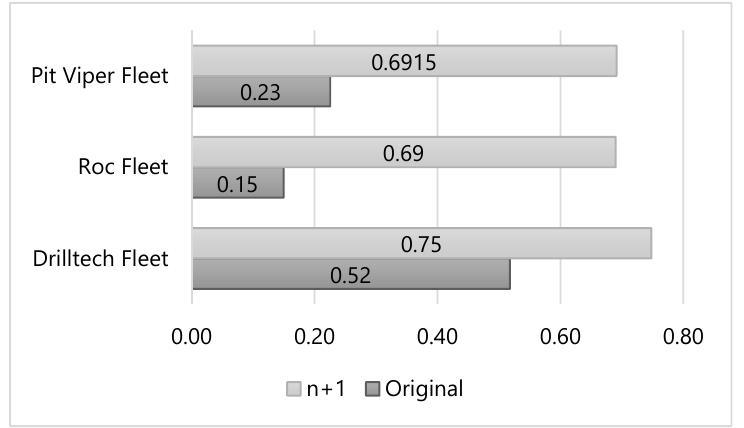
Figure 12. Systemic resilience indexes with original topology and addition of drills.